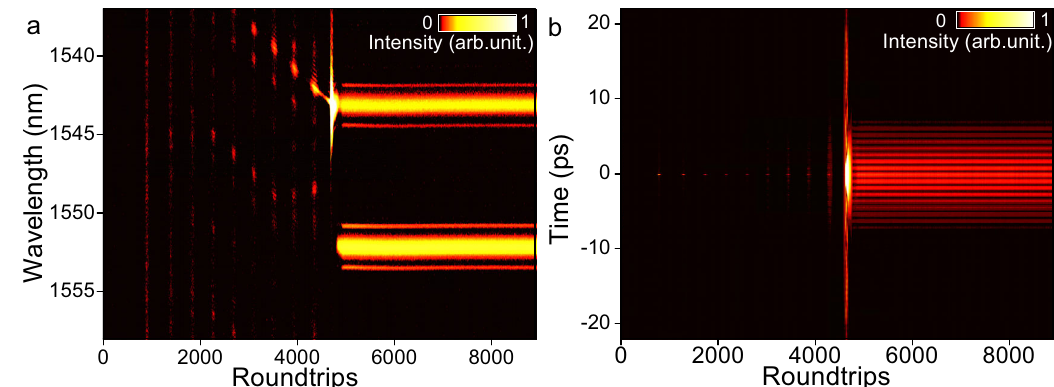
Fig. 3 Buildup dynamics of the synchronized dual-wavelength mode-locked solitons. a Spectra and b fi eld autocorrelation traces.